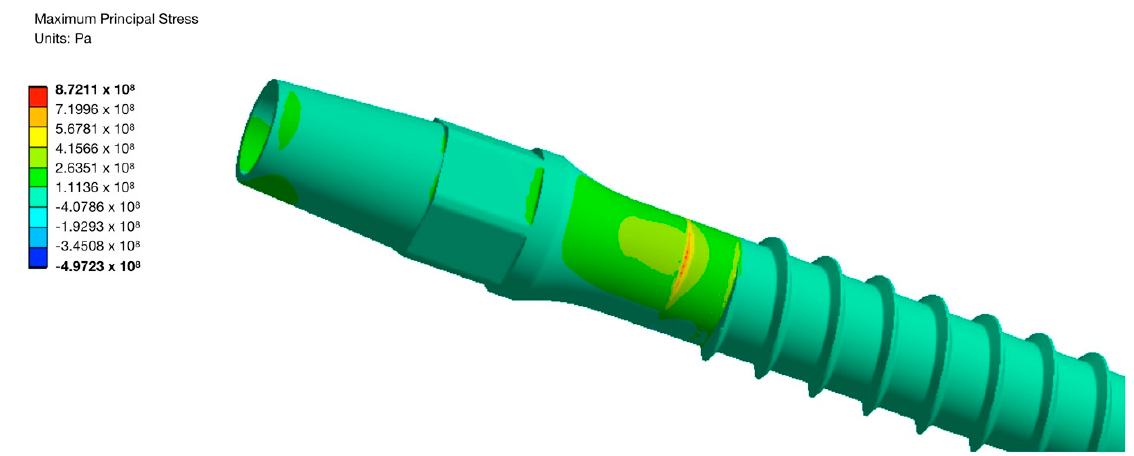
Figure 8. Maximal principal stress for the UFG Ti implant with a 10% reduced diameter and 67.75 N force.